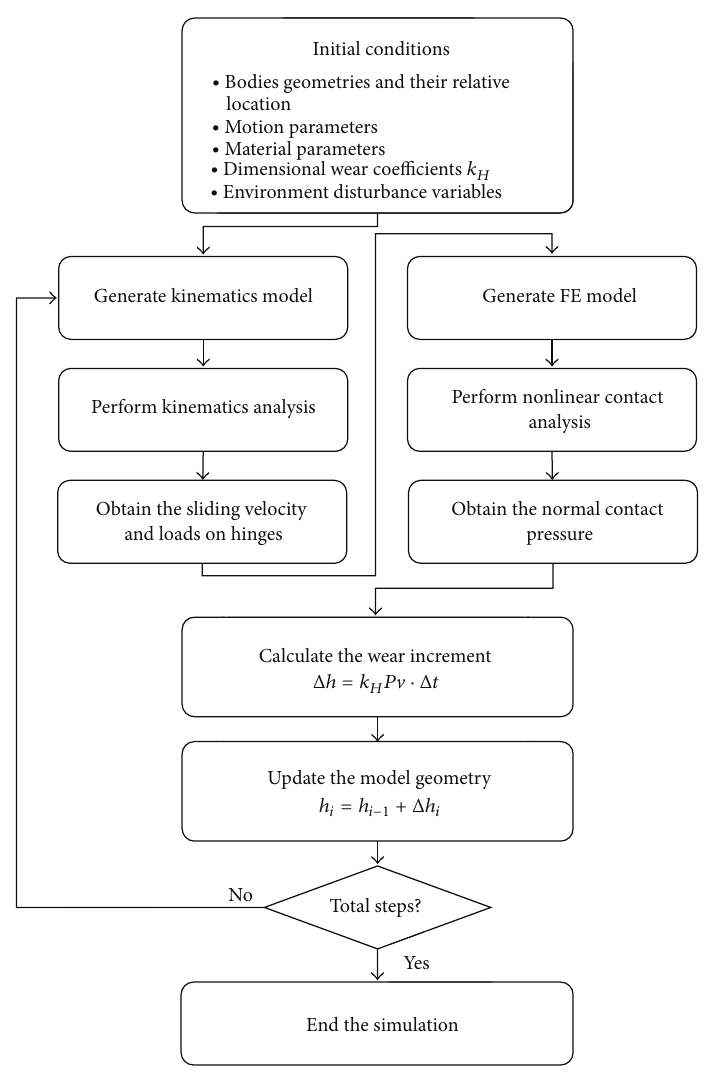
Figure 2: Simulation routine of the multidiscipline reliability model considering